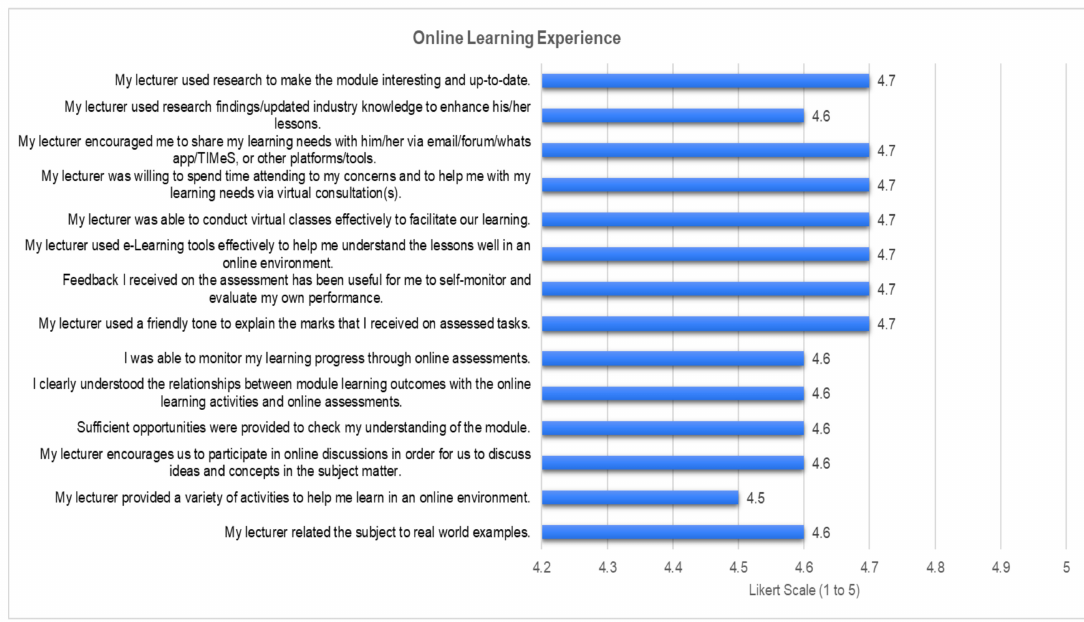
Figure 1. Students’ online learning experience during the Covid-19 pandemic